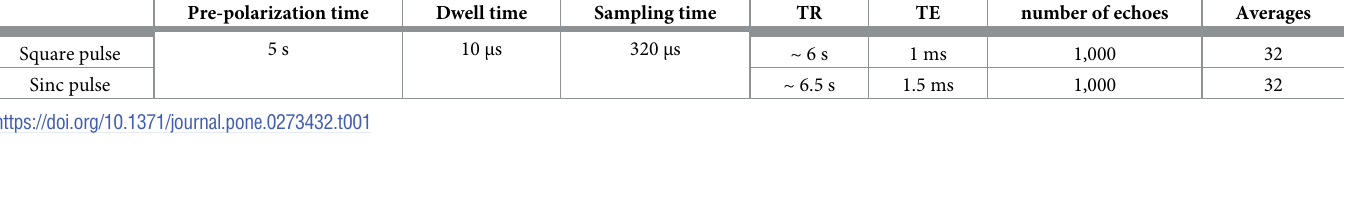
Table 1. NMR signal acquisition parameters used in this study. Pre-polarization